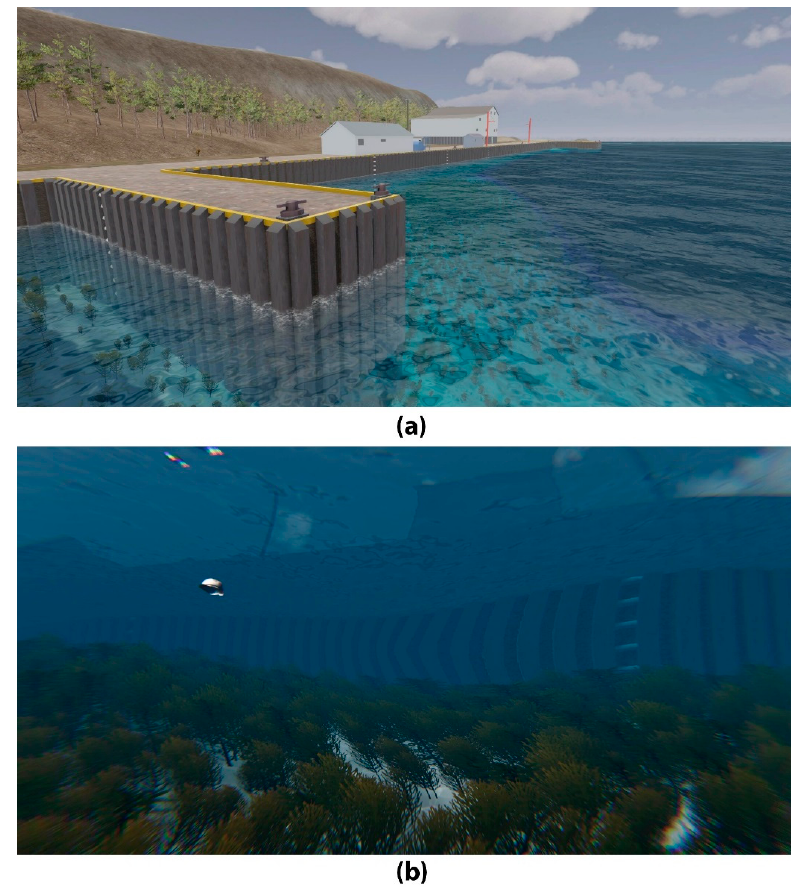
Figure 11. ( a ) View of the virtual wharf, and ( b ) the underwater view.